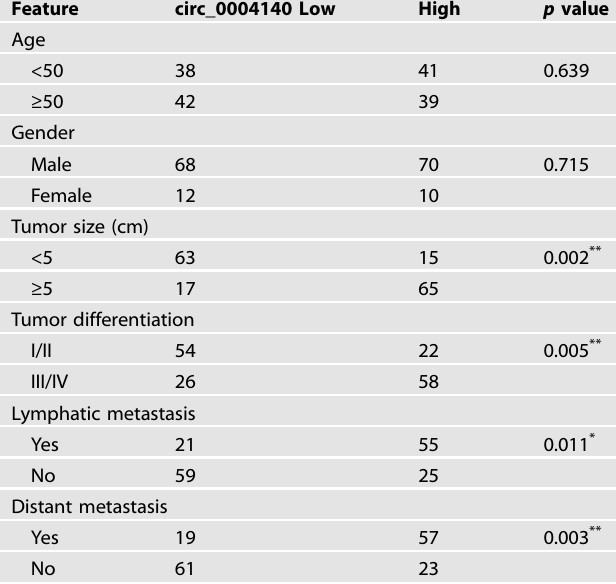
Table 2. Clinical characteristics of LUAD patients according to circ_0004140 expression levels.